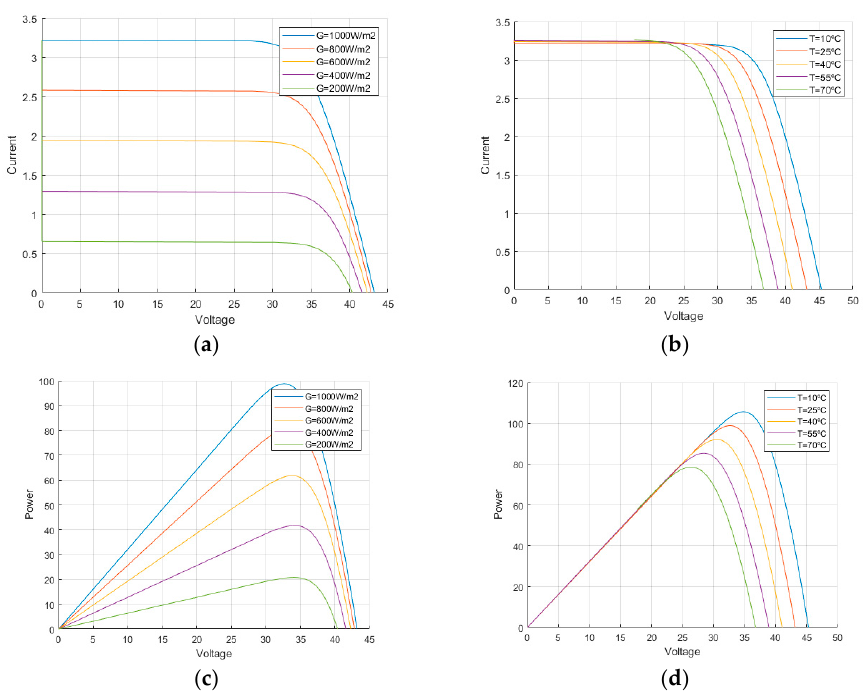
Figure 7. Simulation results of the characteristic curves for SPV model ASE-100-GT-FT considering different irradiations and operating temperatures: ( a , b ) I-V characteristic; ( c , d ) P-V characteristic.